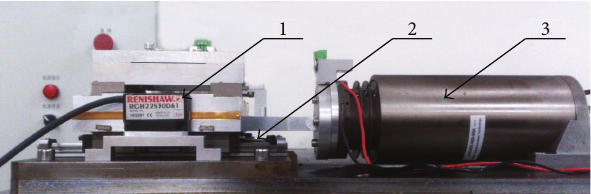
Figure 1: The VCM positioning